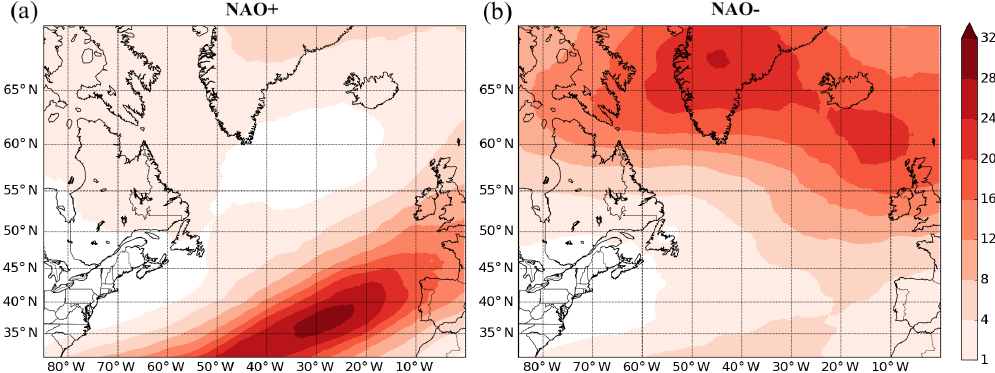
Figure 10. Blocking frequency averaged over (a) positive NAO months and (b) negative NAO months (40-month composites, first and fourth quartiles in winter